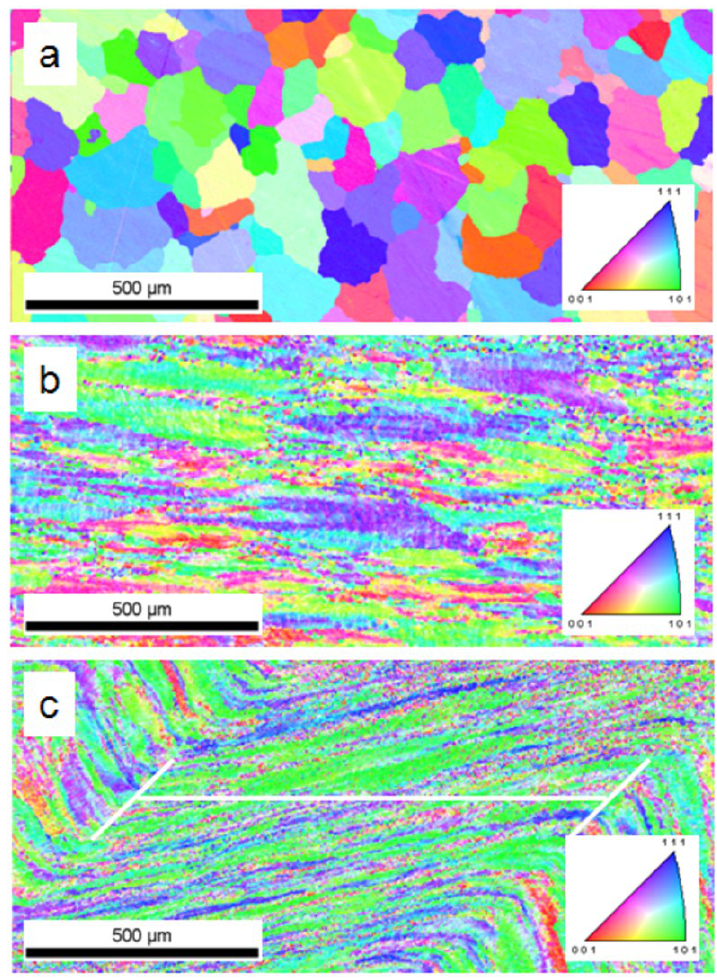
Figure 2. Orientation distribution maps of the material in the ( a ) cast; ( b ) the RT-extruded and ( c ) the ECAP condition showing the grain shape transformation to elongated grains of reduced size and texture evolution by extrusion and ECAP; the shear band in ( c ) is marked by a white